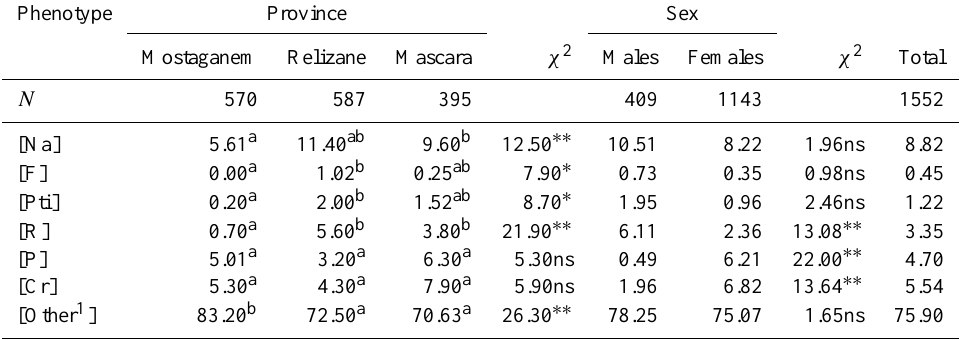
Table 2. Occurrence (%) of major genes carriers in 1552 local chickens from the northwest of Algeria summarized by province and by sex. Phenotype